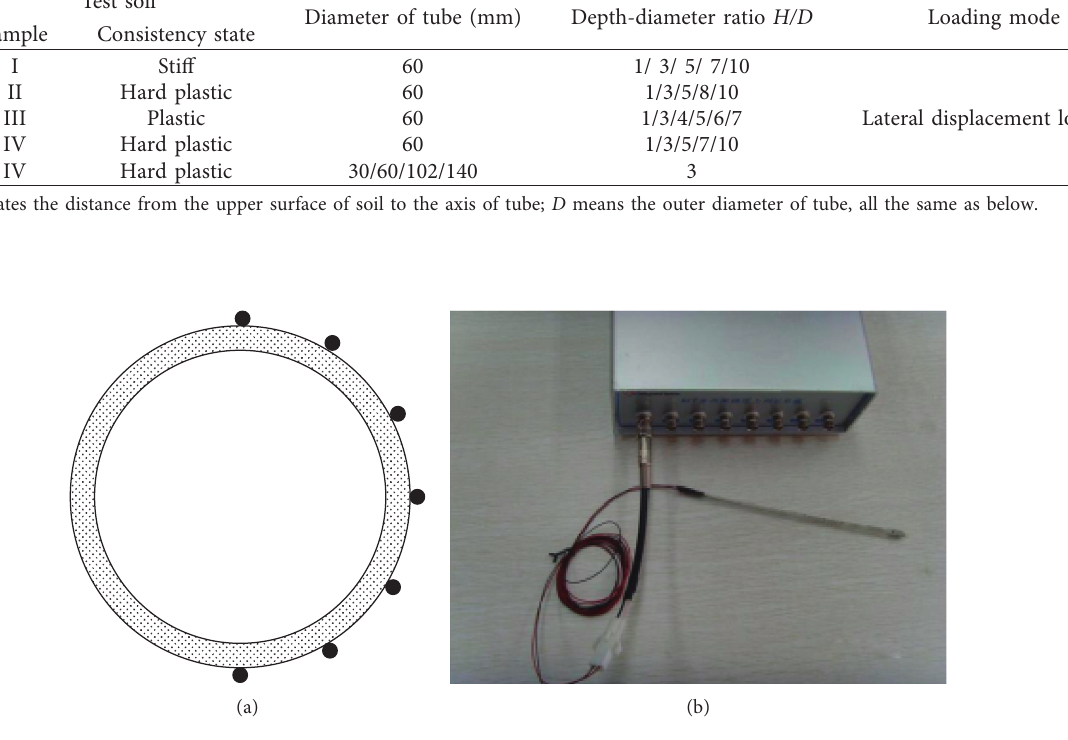
Figure 4: Monitoring of Earth pressure. (a) Location of the pressure sensor on the pipe. (b) Thin film pressure